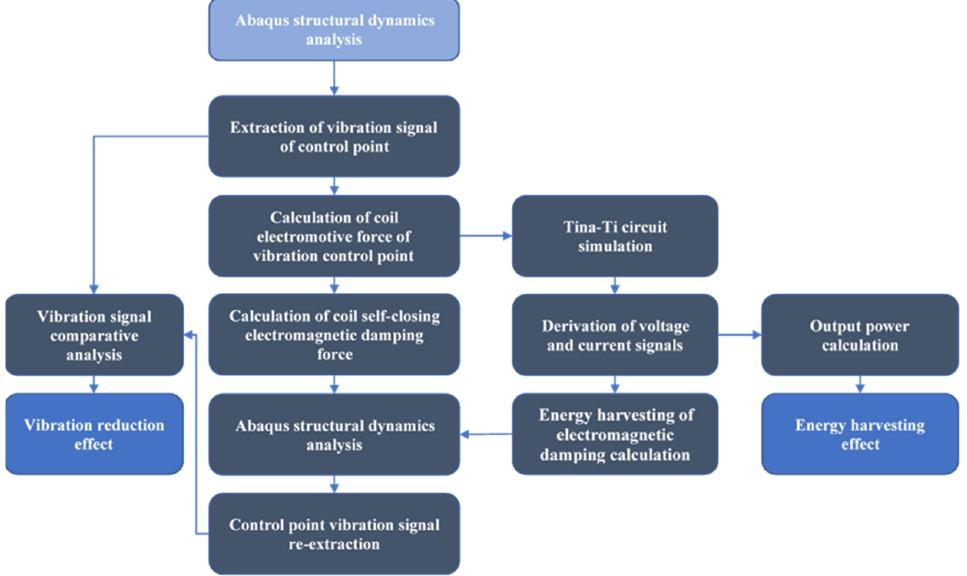
Figure 4. Combined numerical simulation and circuit simulation flow.